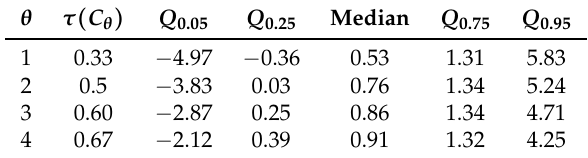
Table 5. Some percentiles of Y = X 1 / X 2 , where ( X 1 , X 2 ) follows Clayton Copulas.